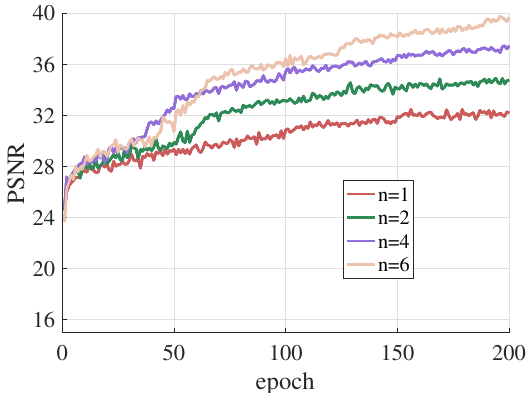
Figure 16. The PSNR comparisons of the proposed CSCNet composed of different numbers of MCSCM during training. n stands for the number of